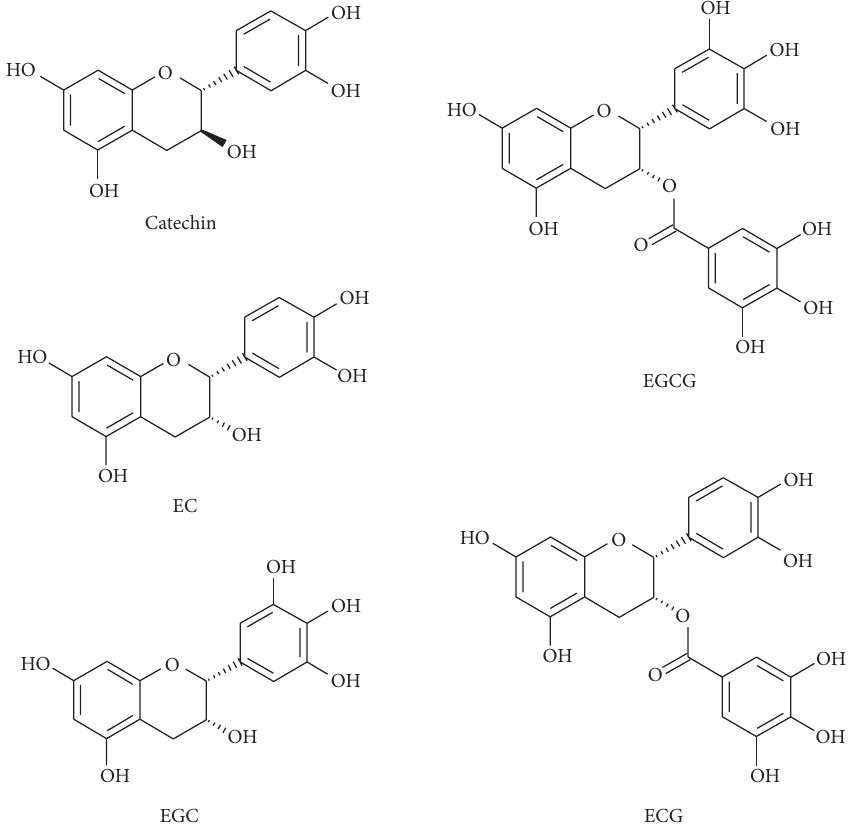
Figure 1: Chemical structures of major catechins present in